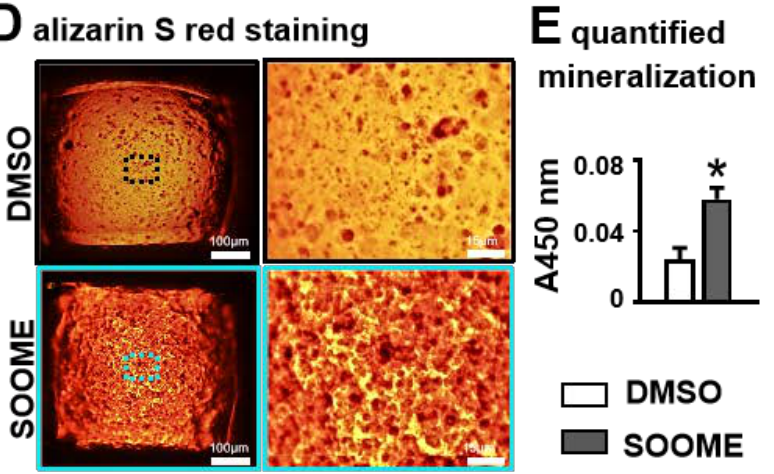
Cells 2022 , 11 , x FOR PEER REVIEW 14 of 20